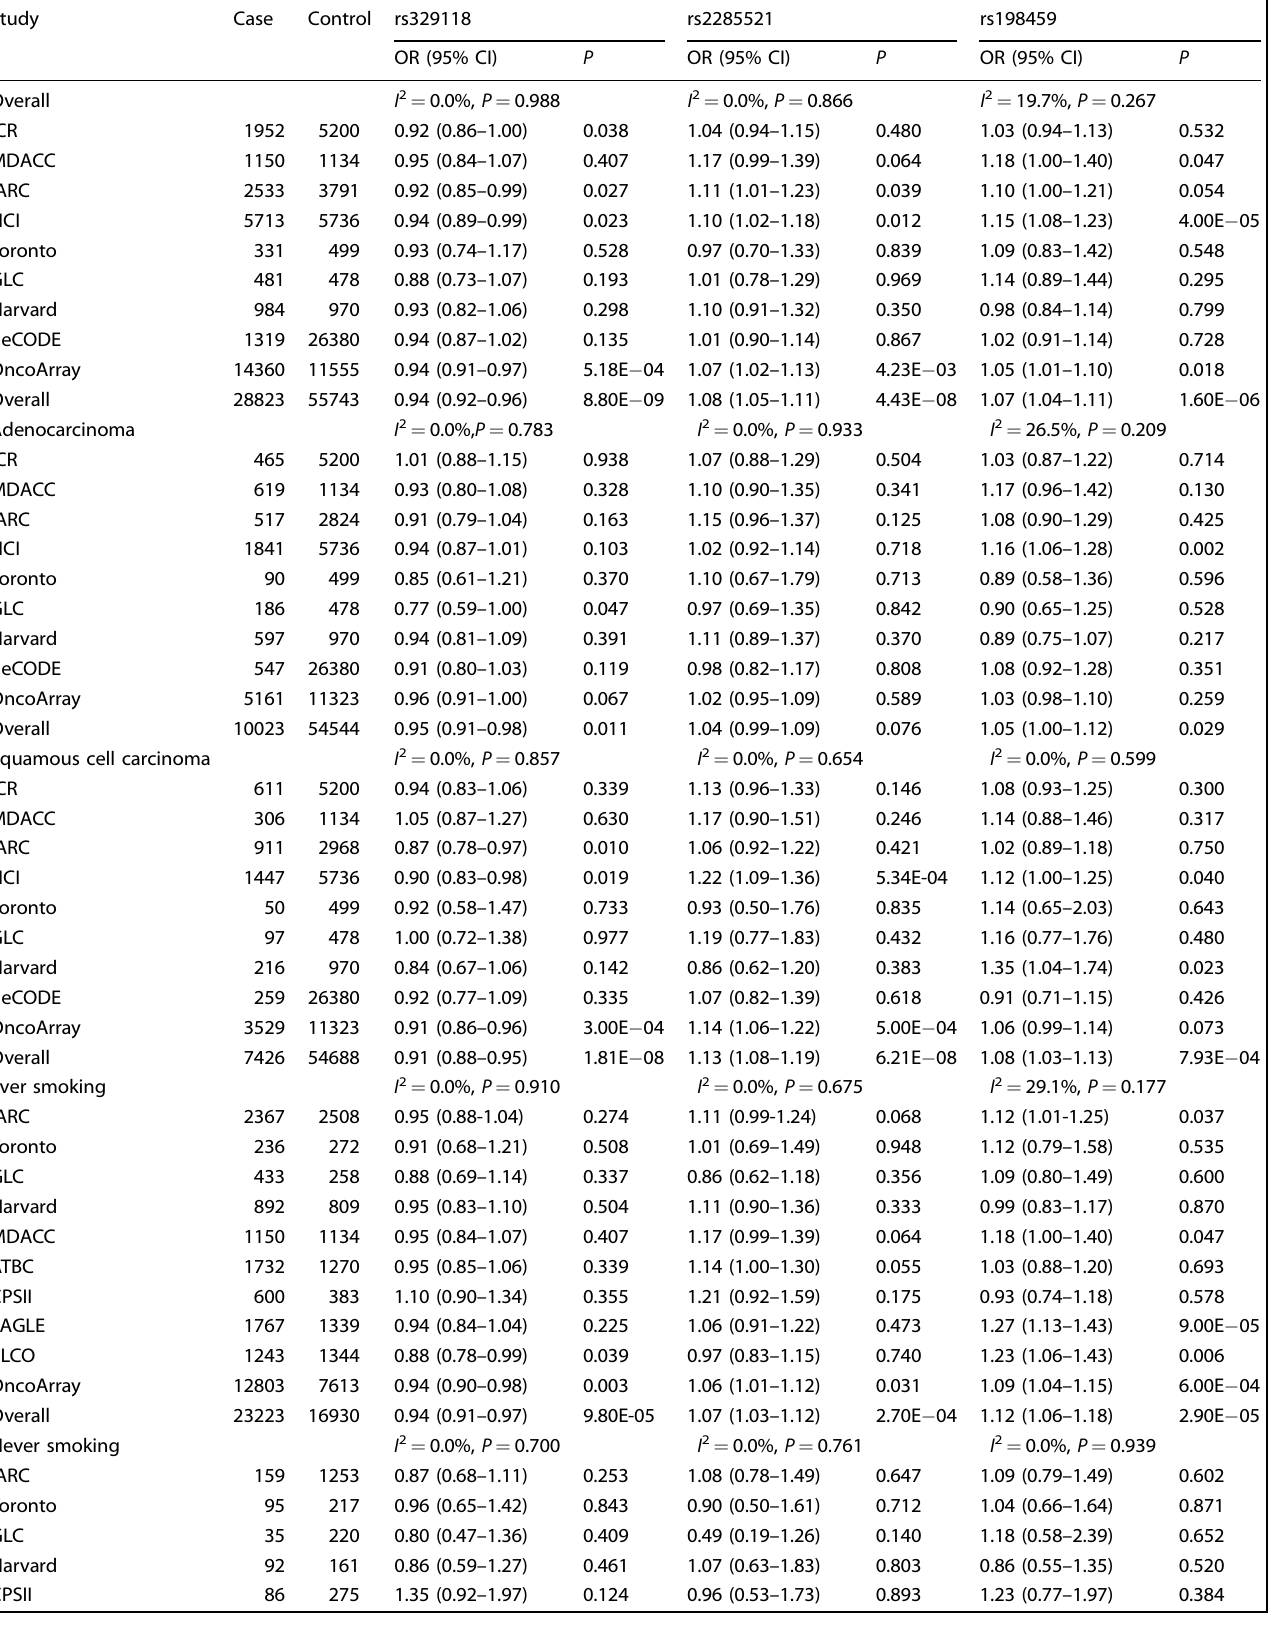
Table 2. Associations between three SNPs and lung cancer risk strati fi ed by histologic types and smoking status in all eight lung cancer GWASs and OncoArray